Question: Describe this figure in one sentence.
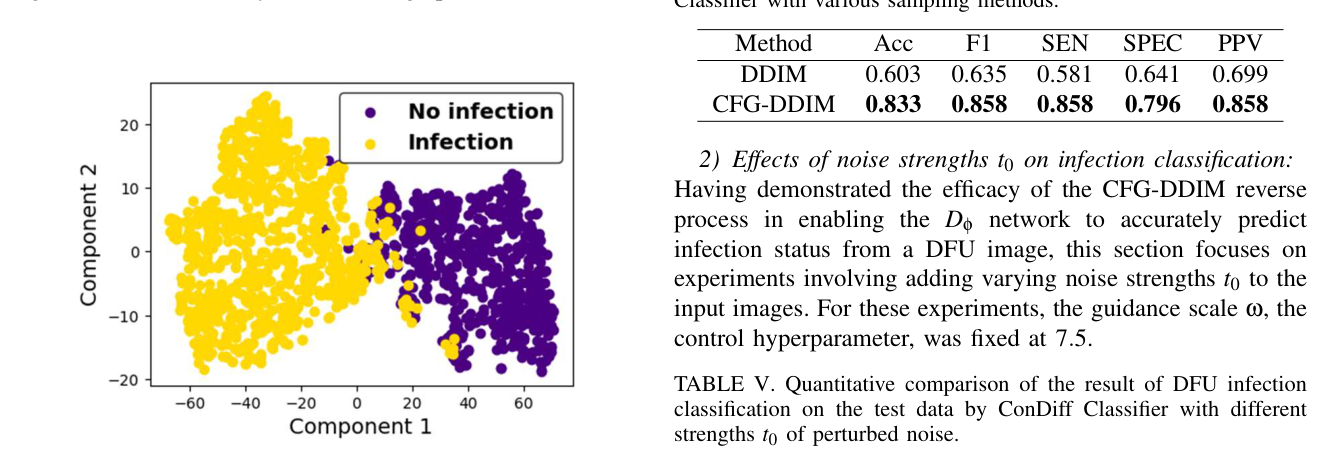
Answer: t-SNE plot of train image embedding computed by fφ.